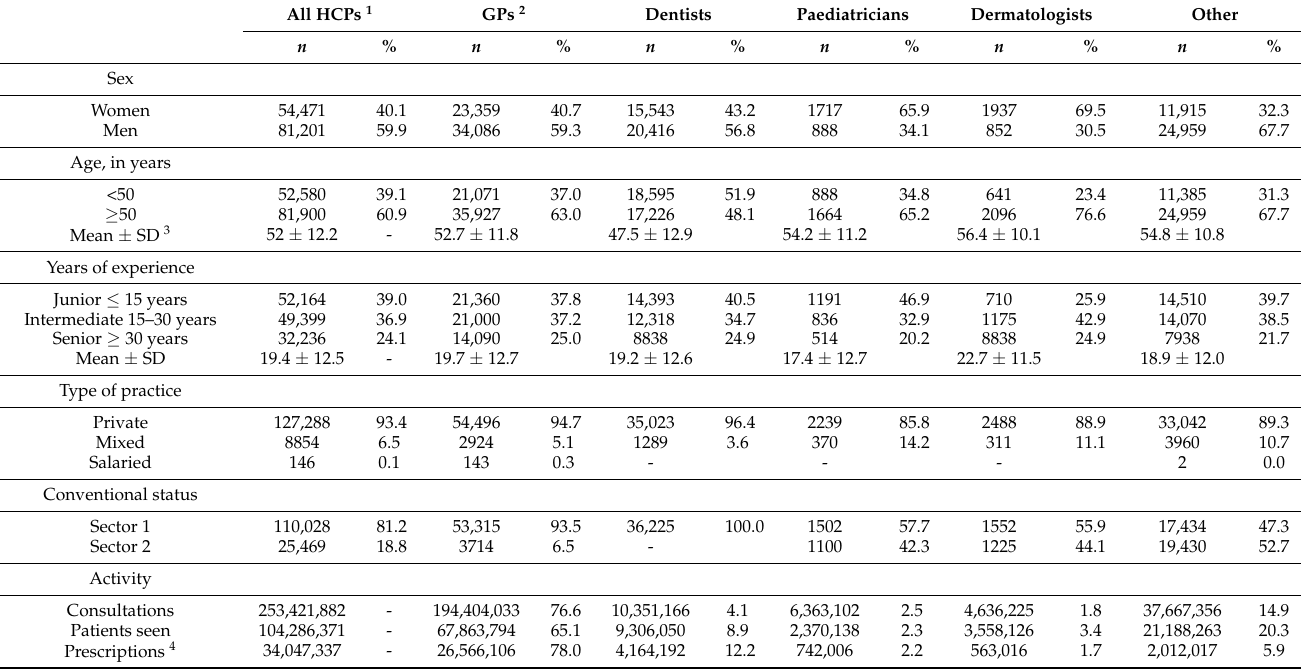
Table 2. Socio-demographic characteristics of antibiotic prescribers, overall and according to subspe- cialty, 2019,